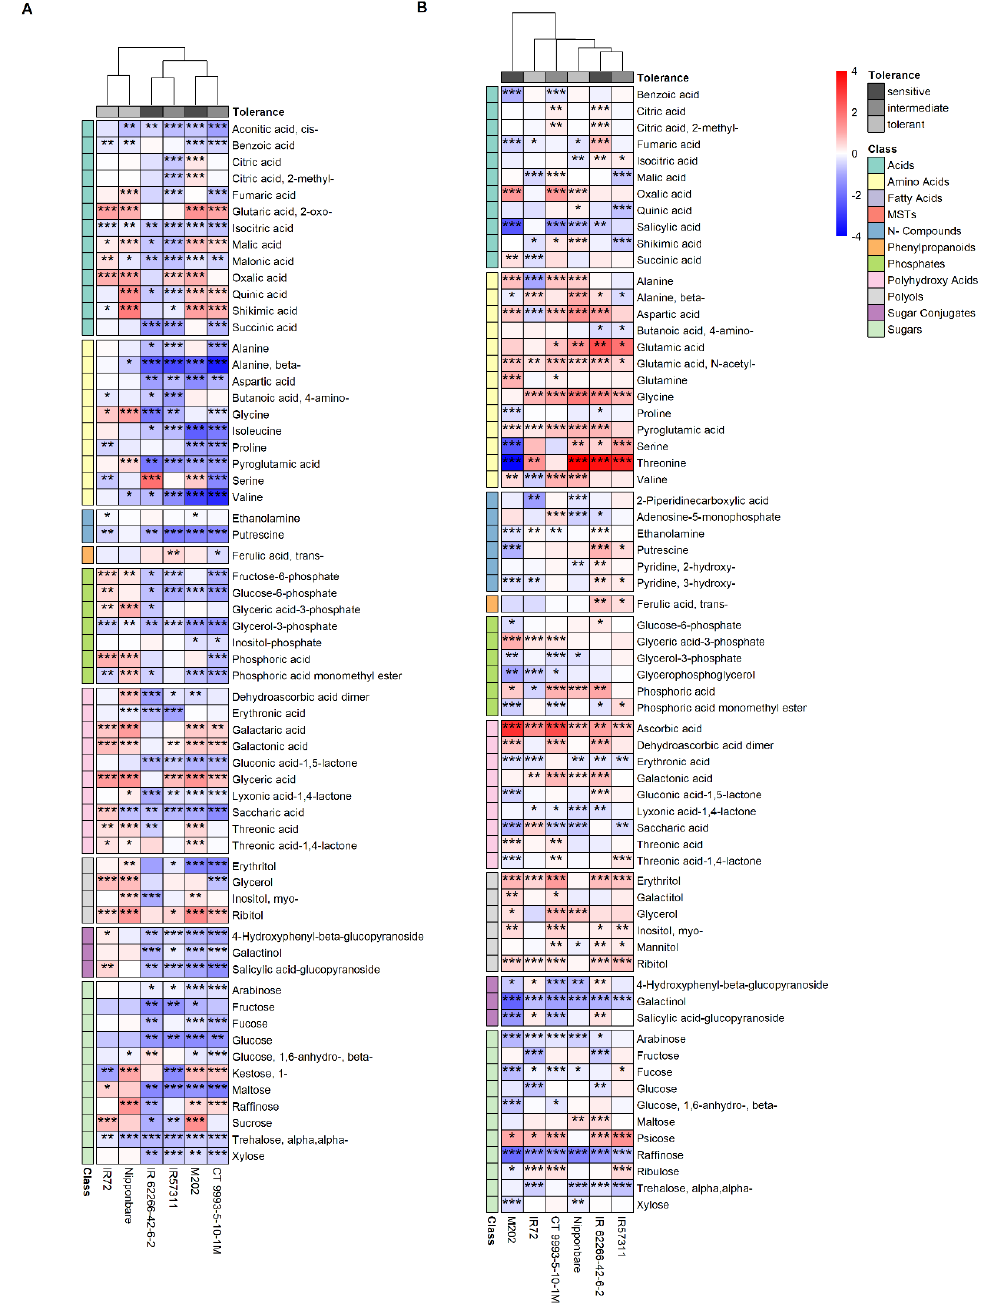
Figure 3. Changes in metabolite levels in leaf sheath ( A ) and base ( B ) segments represented as log 2 fold changes. Red color indicates a higher log 2 fold change, blue color a lower log 2 fold change compared to the control. Asterisks display significance levels of p values: <0.001—***, ≥ 0.001 and ≤ 0.01—**, ≥ 0.01 and ≤ 0.05—*. Tolerance and metabolite classes are color-coded. For a better overview, only known metabolites with significant changes in at least two cultivars are shown.